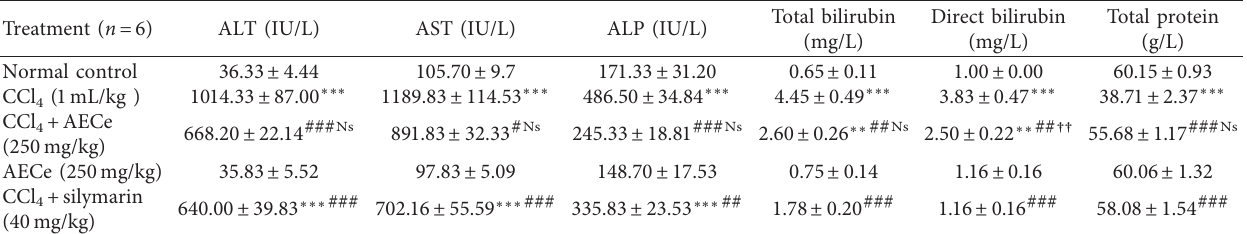
Figure 2: Effect of CCl 4 , AECe (250 mg/kg), and silymarin (40mg/kg) on liver weight (a) and liver index (b). Values are mean ± SEM ( n and analyzed with one-way ANOVA followed by Tukey’s test. ∗∗∗ p < 0 . 001 vs. control group. ### p < 0 . 001 vs. CCl 4 group. Table 1: Effect of aqueous extract of Caralluma europaea against carbon tetrachloride-induced hepatotoxicity-related parameters in rats. Treatment ( n �